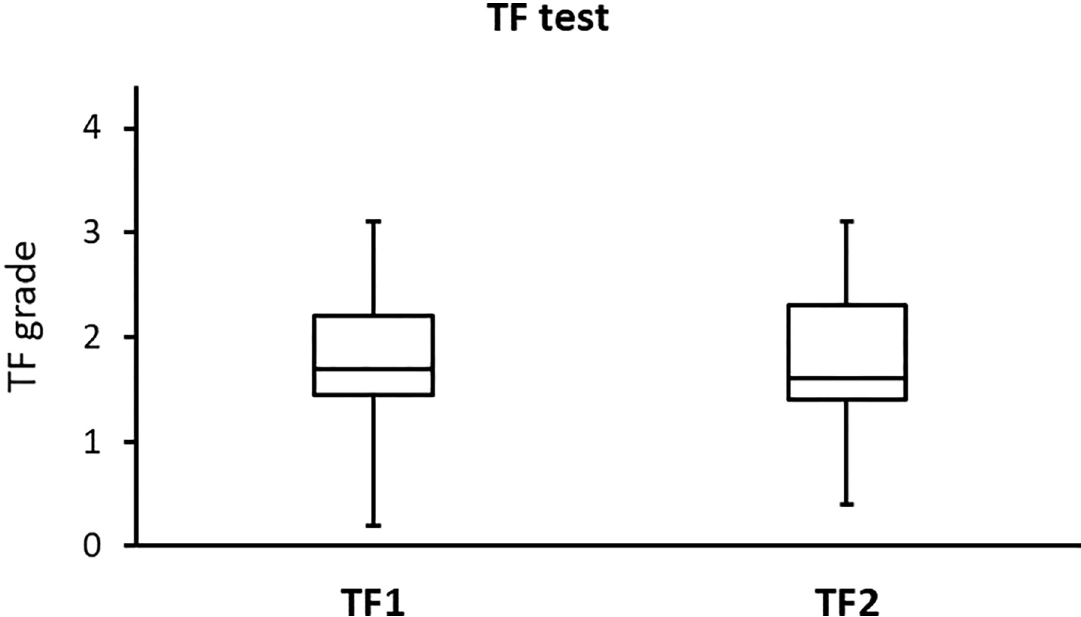
Fig 3. Side-by-side boxplots for the TF grades for the subjects with a high BMI before (TF1) and after (TF2) wearing a surgical face